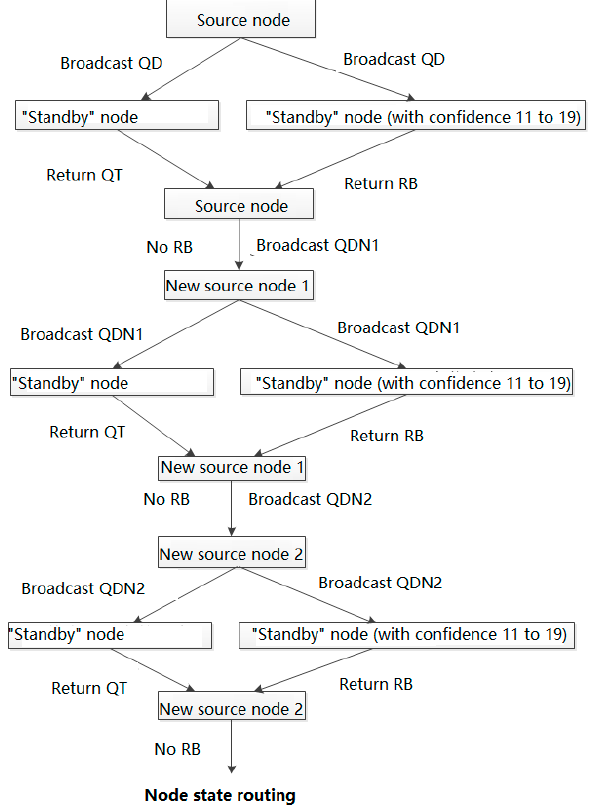
Figure 11. Determining the destination node.